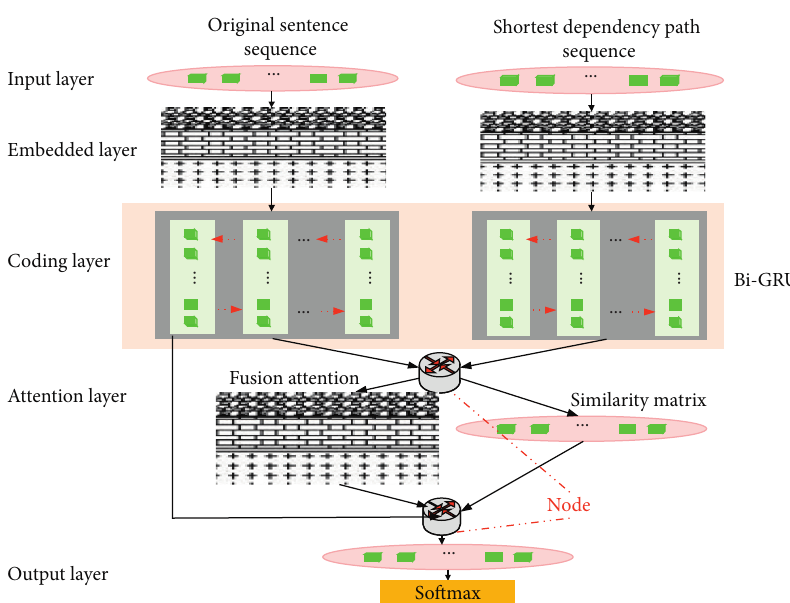
Figure 2: Schematic diagram of the framework of the drug relationship network model based on the attention mechanism in this study.